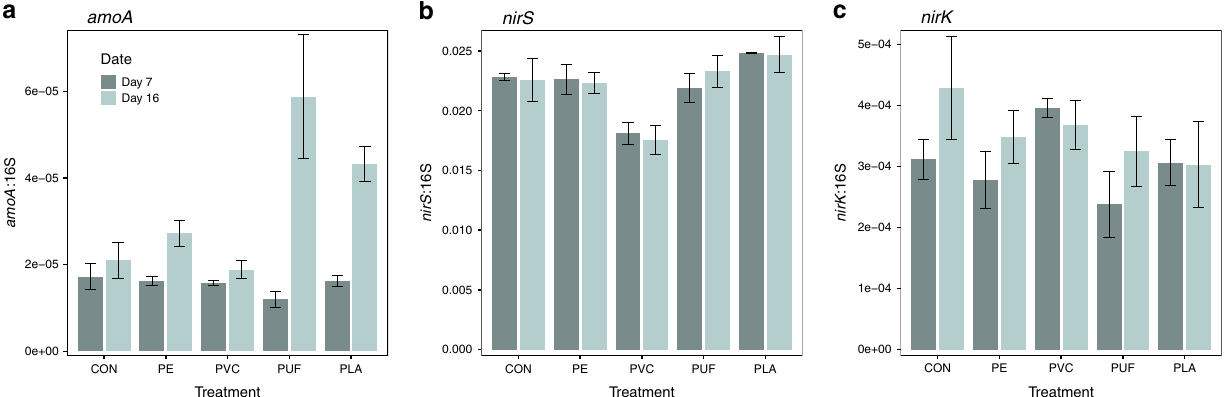
Fig. 5 Nitri fi cation and denitri fi cation gene abundances. The genes encoding ammonia monooxygenase ( amoA , a ) and nitrite reductase ( nirS, b , and nirK, c ) were quanti fi ed and normalized to 16S rRNA genes. Error bars are standard error ( n = 3 per treatment) and CON is the control treatment. Initial community ratios are 1.85e − 5, 3.03e − 2 and 3.25e − 4 for amoA , nirS , and nirK . Statistical analyses can be found in Supplementary Tables 6 –